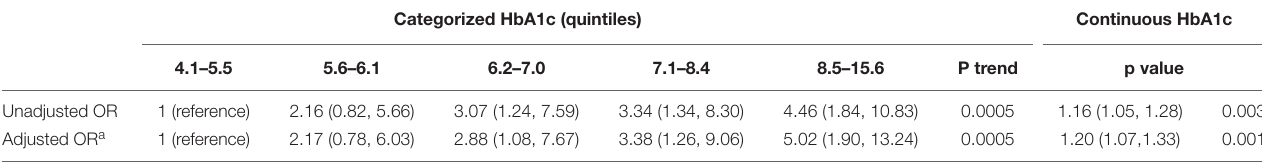
TABLE 2 | Associations of pre-operative glycosylated hemoglobin A1c with acute kidney injury after non-cardiac surgery.